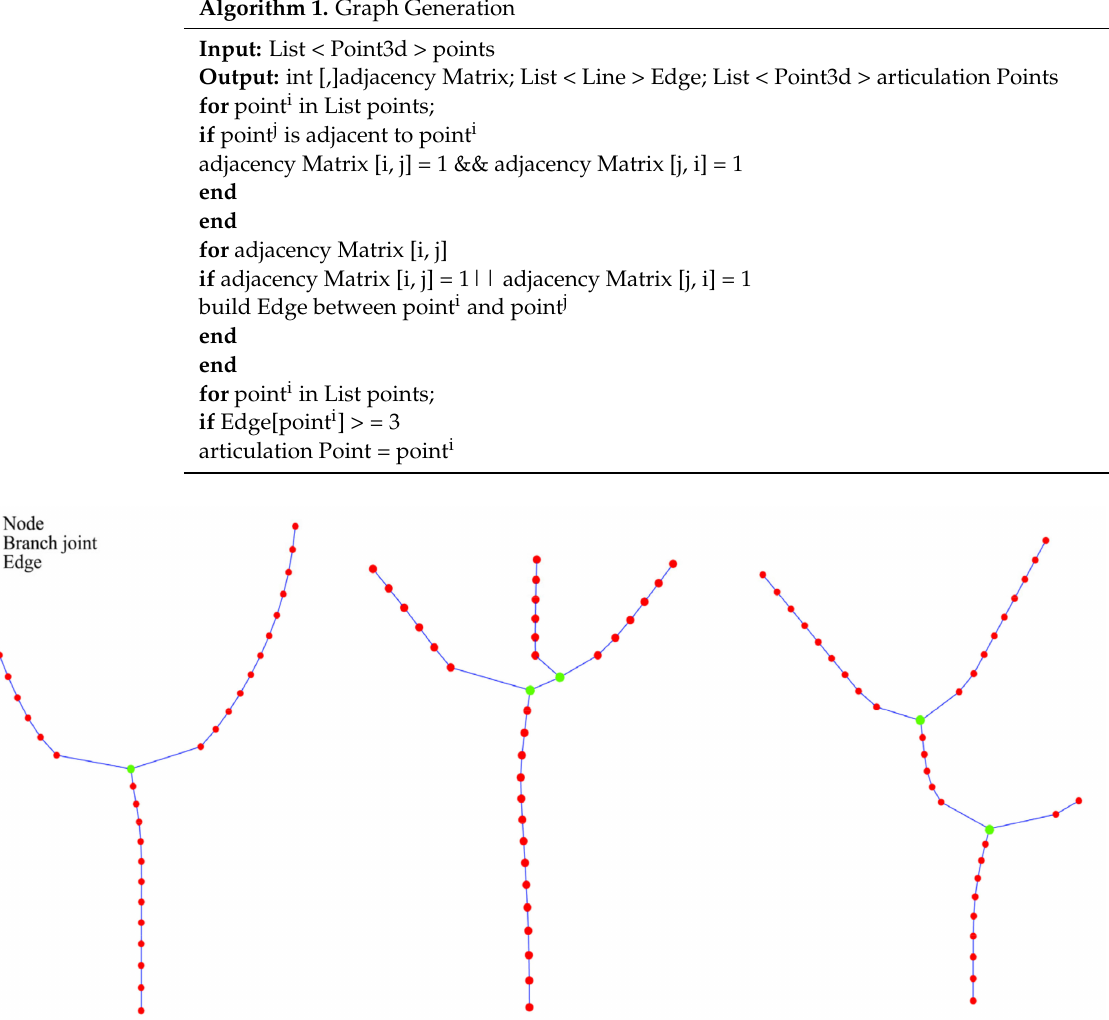
Figure 5. Undirected graph of the three